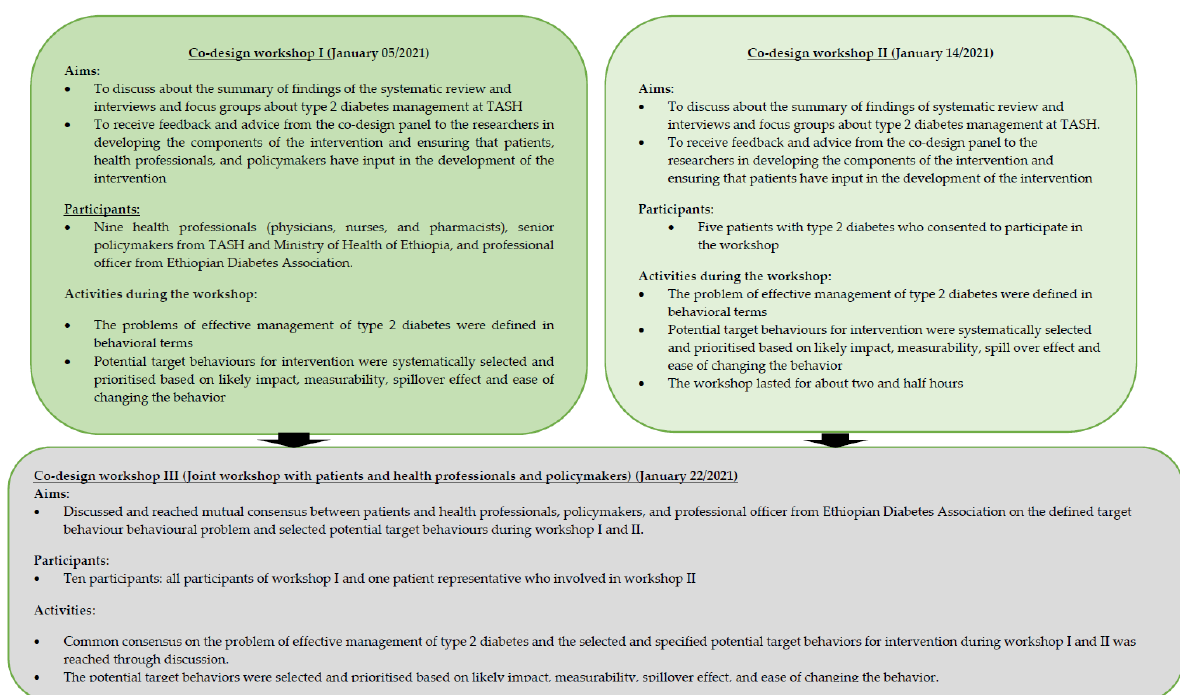
Figure 2. Activities undertaken in the co-design